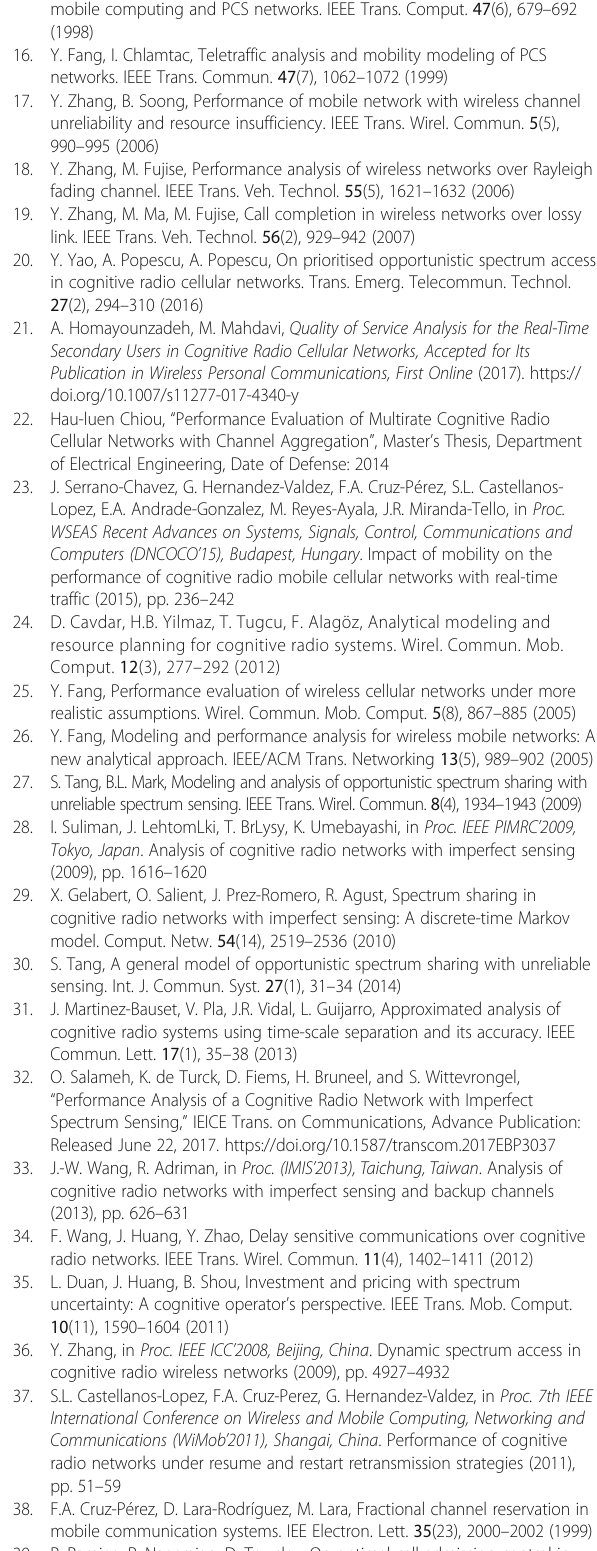
GHV was involved in the development of the different mathematical models as well as identifying, analyzing, and studying the different factors that affect system performance. MERA was involved in the mathematical analysis as well as in the numerical evaluation of the considered system. All authors read and approved the final